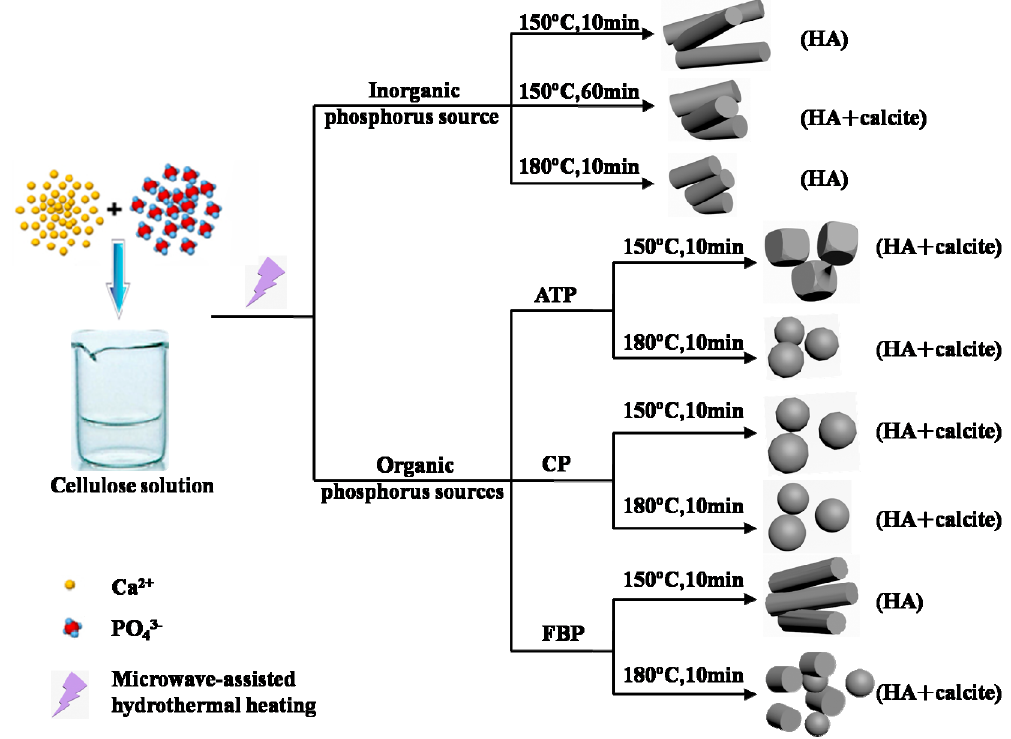
Figure 9. Schematic illustration of the synthetic strategies and results for the cellulose/HA nanocomposites using inorganic (NaH 2 PO 4 · 2H 2 O) and organic (ATP, CP, and FBP) phosphorus sources through microwave-assisted hydrothermal method.